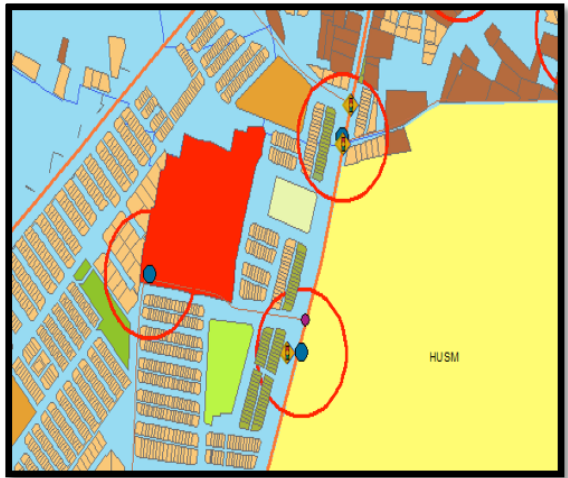
Figure 1. 100-meter buffer analysis using ARCGIS ® software